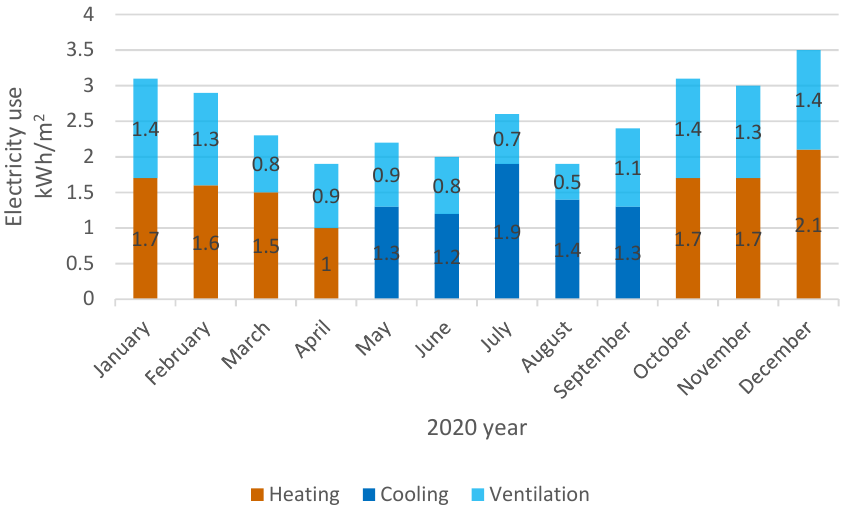
Figure 5. The building “A”’s annual electricity consumption for heating, cooling and ventilation (2020 data).